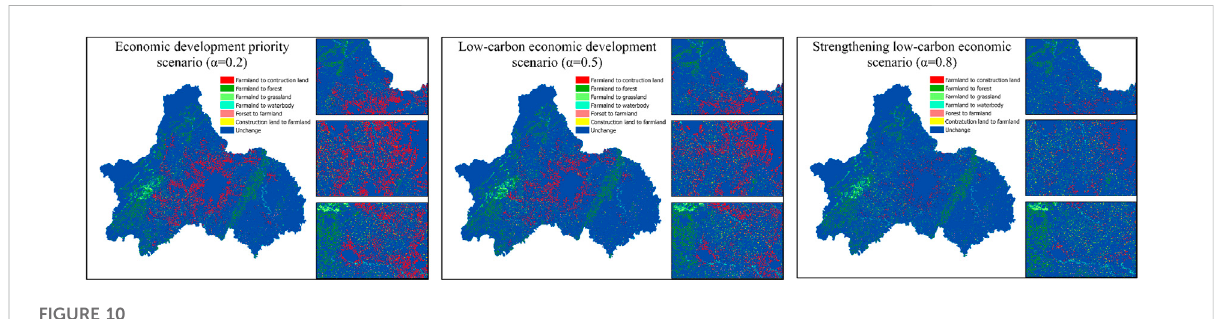
FIGURE 10 Distribution of main transfer in land use types under three